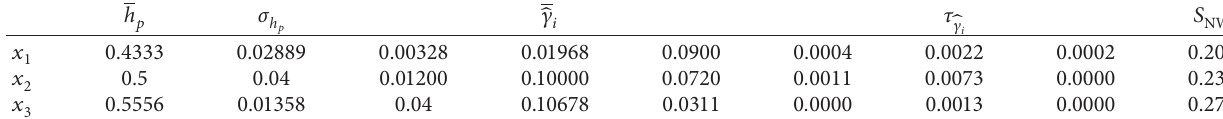
Table 2: Mean value and deviation value of